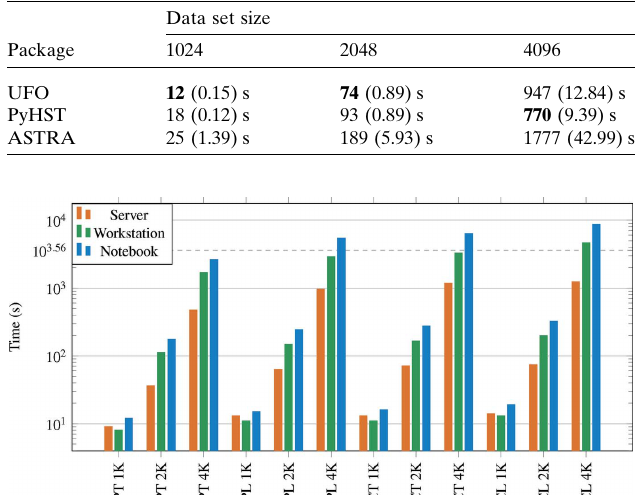
Figure 10 Filtered back projection compute times required by tofu on different systems, data set sizes (1K = 1024, 2K = 2048, 4K = 4096) and geometries (P = parallel, C = cone, T = tomography, L = laminography). One hour mark is shown as a dashed horizontal